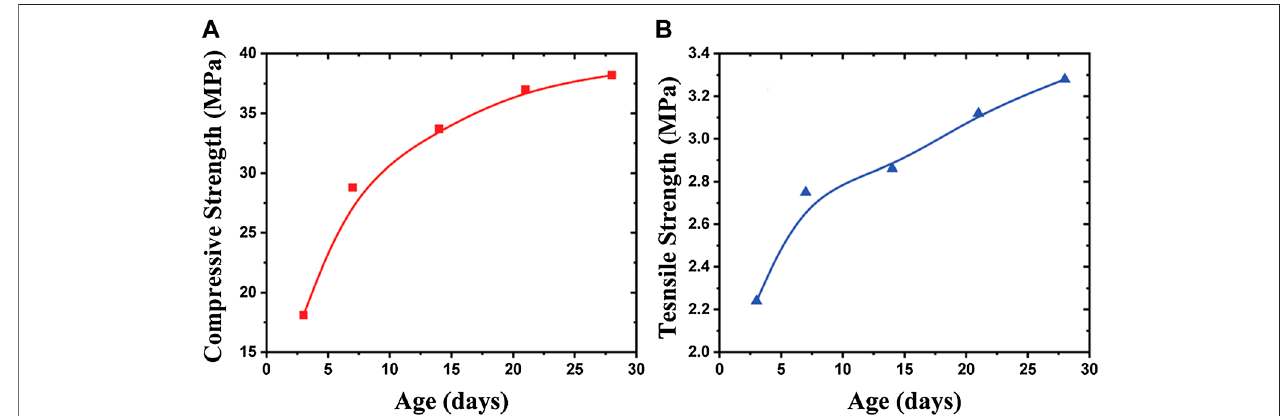
FIGURE 4 | Tensile-compressive strength ratio of CGCLWAC in different ages.